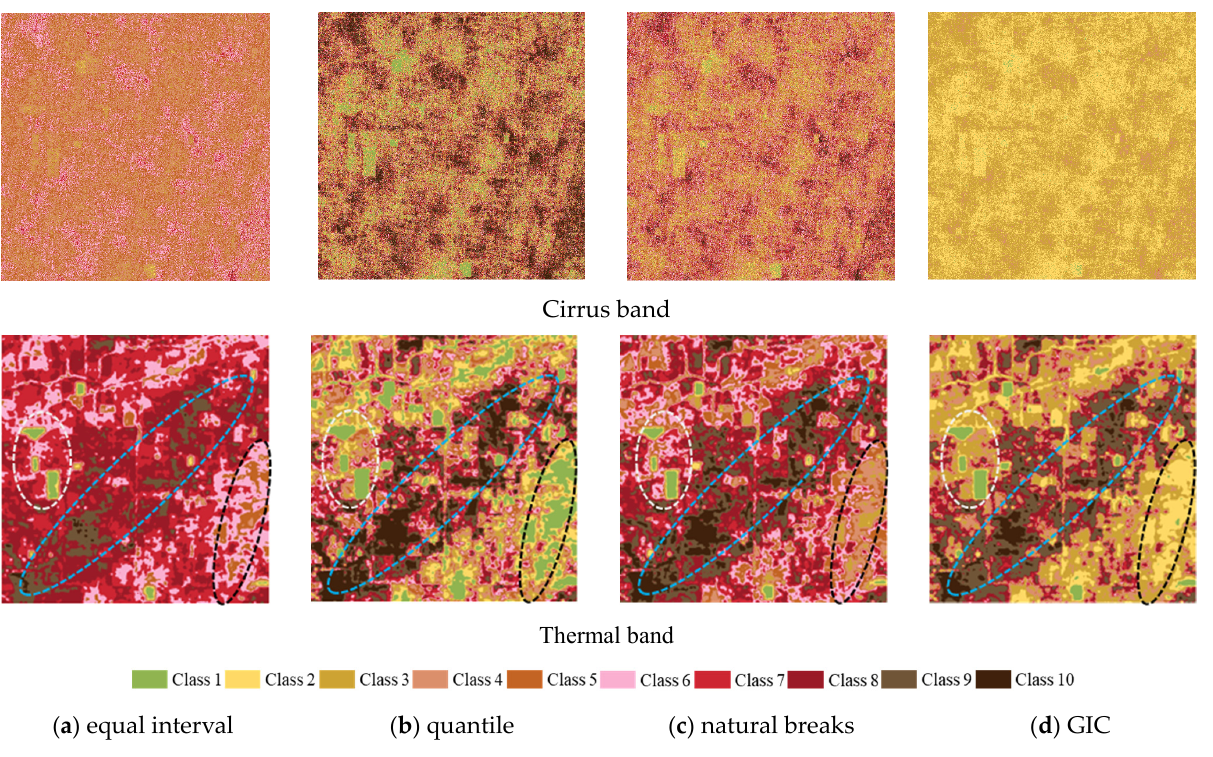
Figure 12. Comparison results using the equal interval ( a ), quantile ( b ), natural breaks ( c ), and GIC ( d ) methods for the population data of Indiana, Chicago, and simulated population data of Georgia, and the blue, cirrus, and thermal bands of the Landsat image. Table 5. Fisher’s linear discriminants, including the within-class metric ( S W ), between-class metric ( S B ) and the ratio S B / S W for different classification